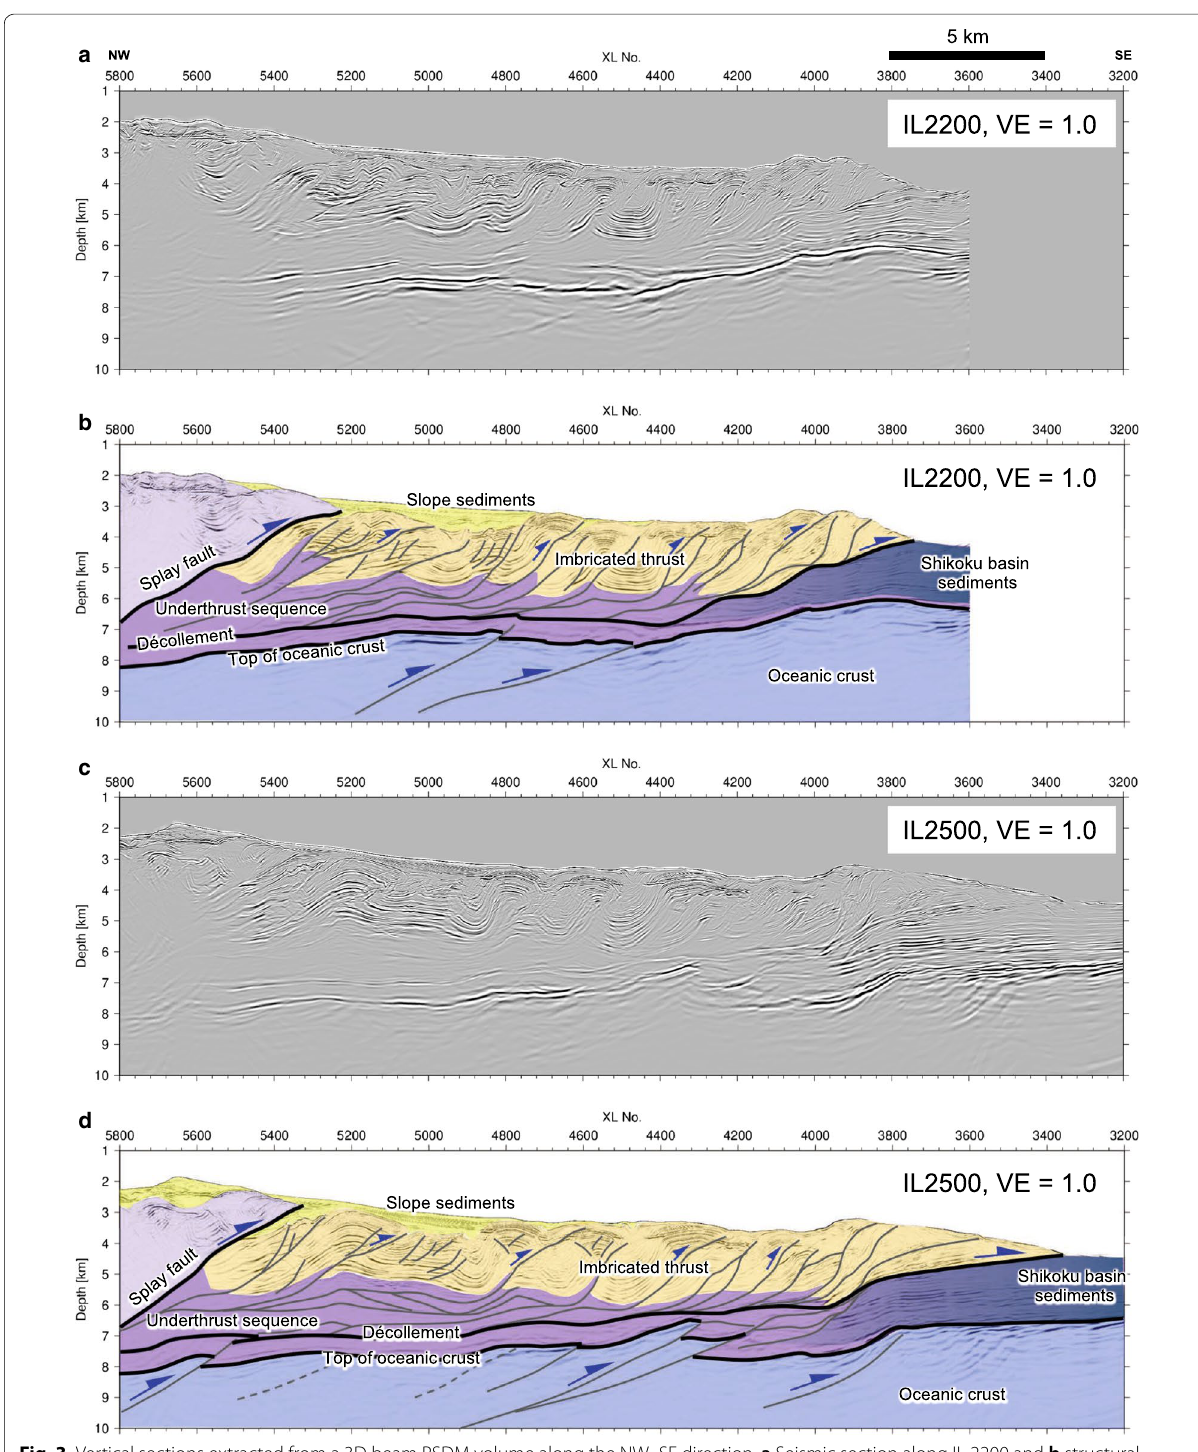
Fig. 3 Vertical sections extracted from a 3D beam PSDM volume along the NW–SE direction. a Seismic section along IL 2200 and b structural interpretation of ( a ). c Seismic section along IL 2500, and d structural interpretation of ( c ). Vertical exaggeration (VE) is 1.0 for all sections in this